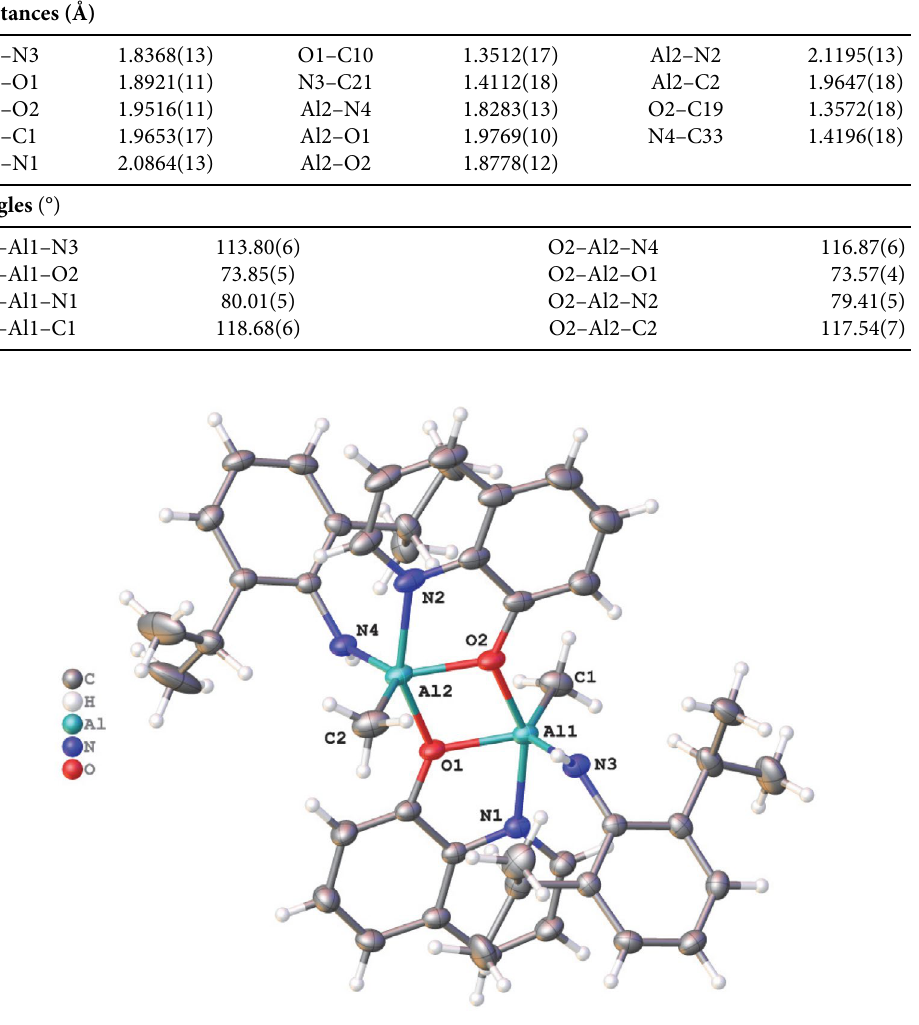
Figure 1. Thermal ellipsoid plot of 2 (disordered solvent molecule was omitted for